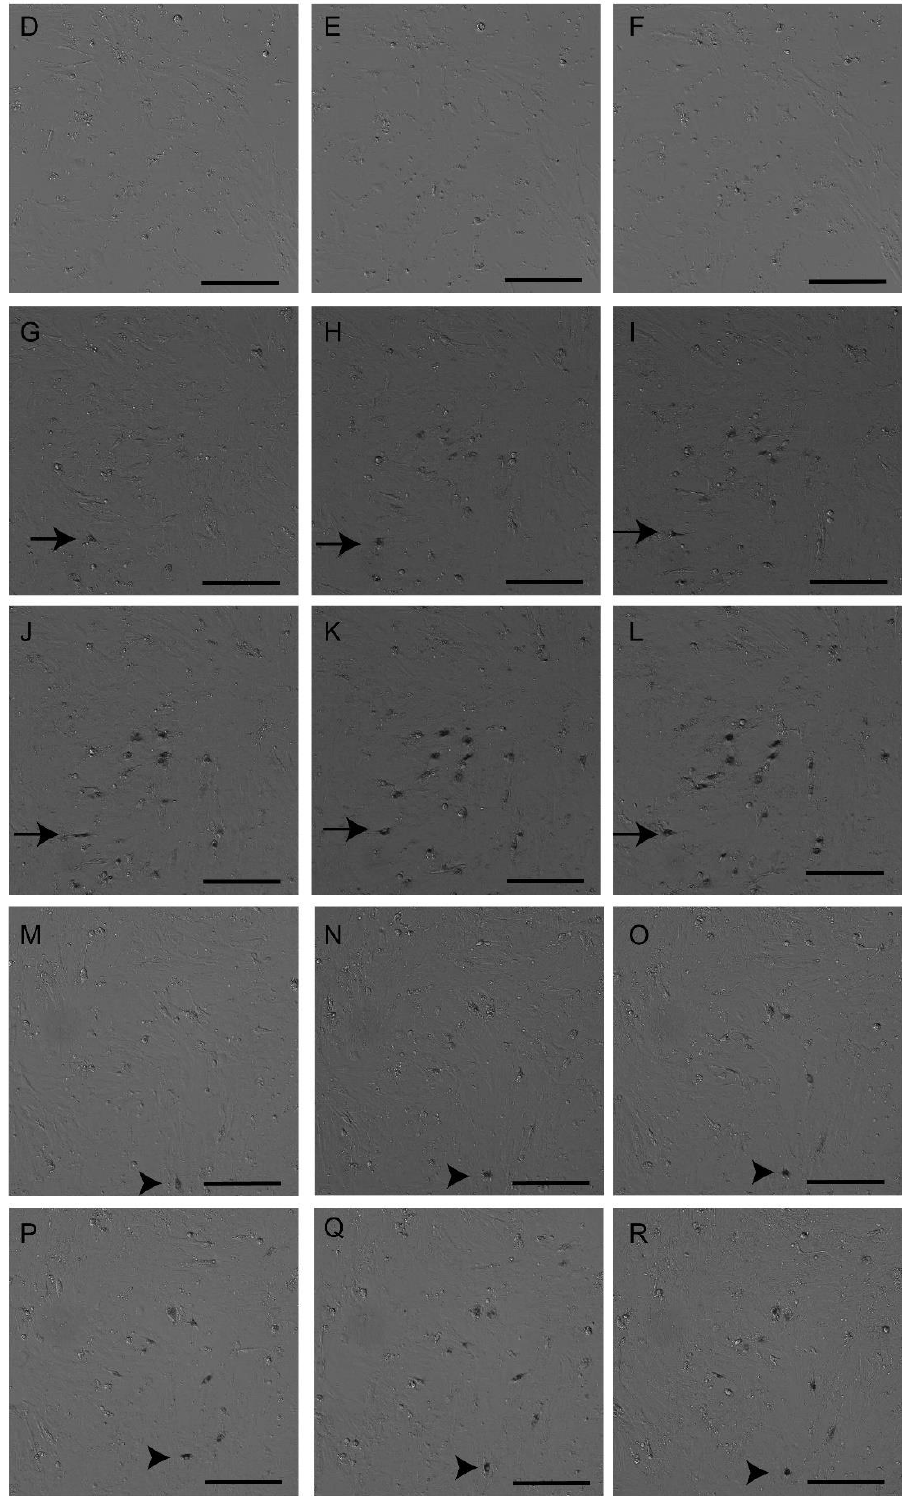
Figure 5. Incubation of Adipose-derived stromal cells (ASCs) with Laser ablated Albumin functional- ized AuNPs (LA-AuNPs) for 24 h. Serial images of control without LA-AuNPs ( A – F ), cells exposed to 2 nm LA-AuNPs in the dilution 1:1 ( G – L ), and 53 nm LA-AuNPs in the dilution 1:1 ( M – R ). The sequence of images from after 6 h and 40 min ( A , G , M ), 10 h ( B , H , N ), 13 h and 20 min ( C , I , O ), 16